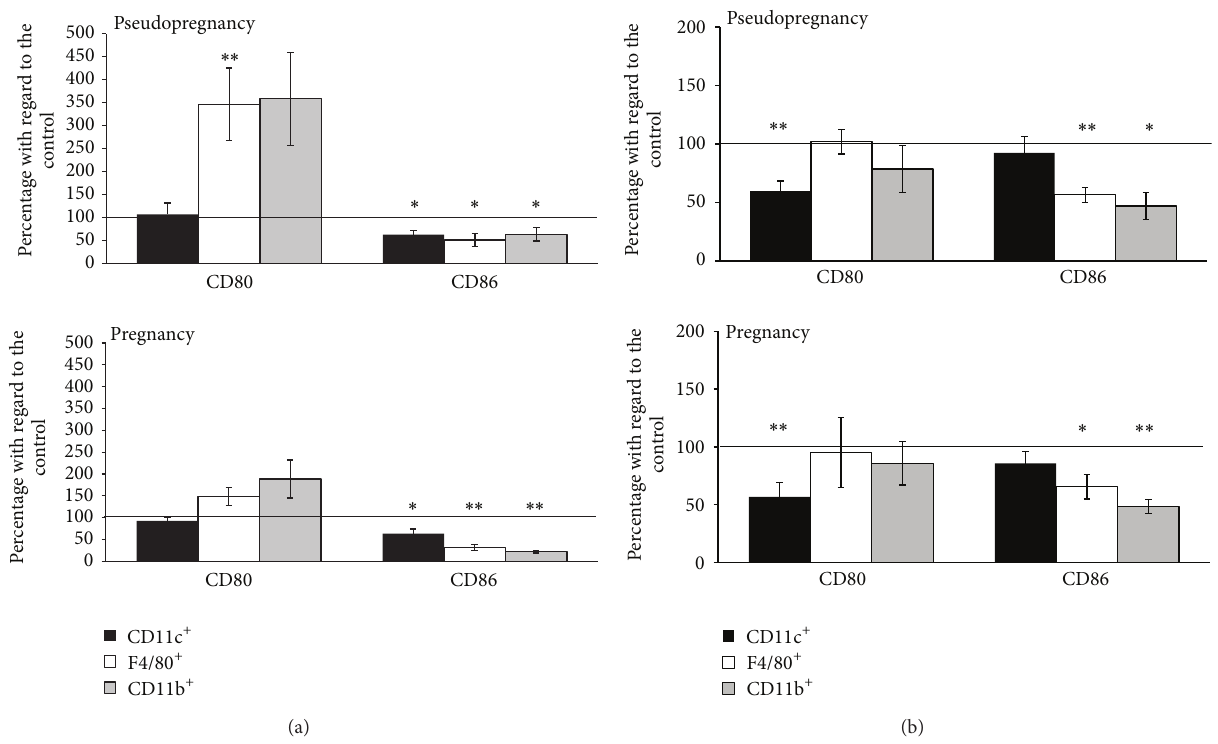
Figure 1: Proliferation and activation of OVA-specific T cells cocultured with splenic APCs isolated from mated or pseudopregnant female mice after blockade of CD80 and CD86. (a) Proliferation estimated by BrdU incorporation and ELISA. Data were presented as percentages of absorbance for blocked molecules in comparison with isotype control (mean ± SEM). (b) Activation of T cells was expressed as the ratio of total number of CD4 + CD25 + cells to the total number of CD4 + CD25 − cells. Data were presented as percentages of CD4 + CD25 + /CD4 + CD25 − forblockedmoleculesincomparisonwithisotypecontrol(mean ± SEM). 𝑁 = 10 animalspergroup;Student’s t -test(parametric)orWilcoxon (nonparametric) test, ∗ 𝑃 < 0.05 ; ∗∗ 𝑃 < 0.01 .